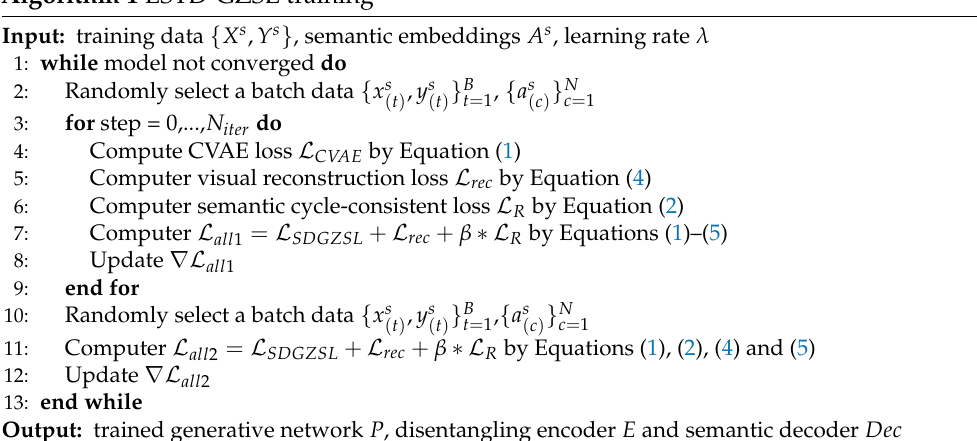
Algorithm 1 ESTD-GZSL training